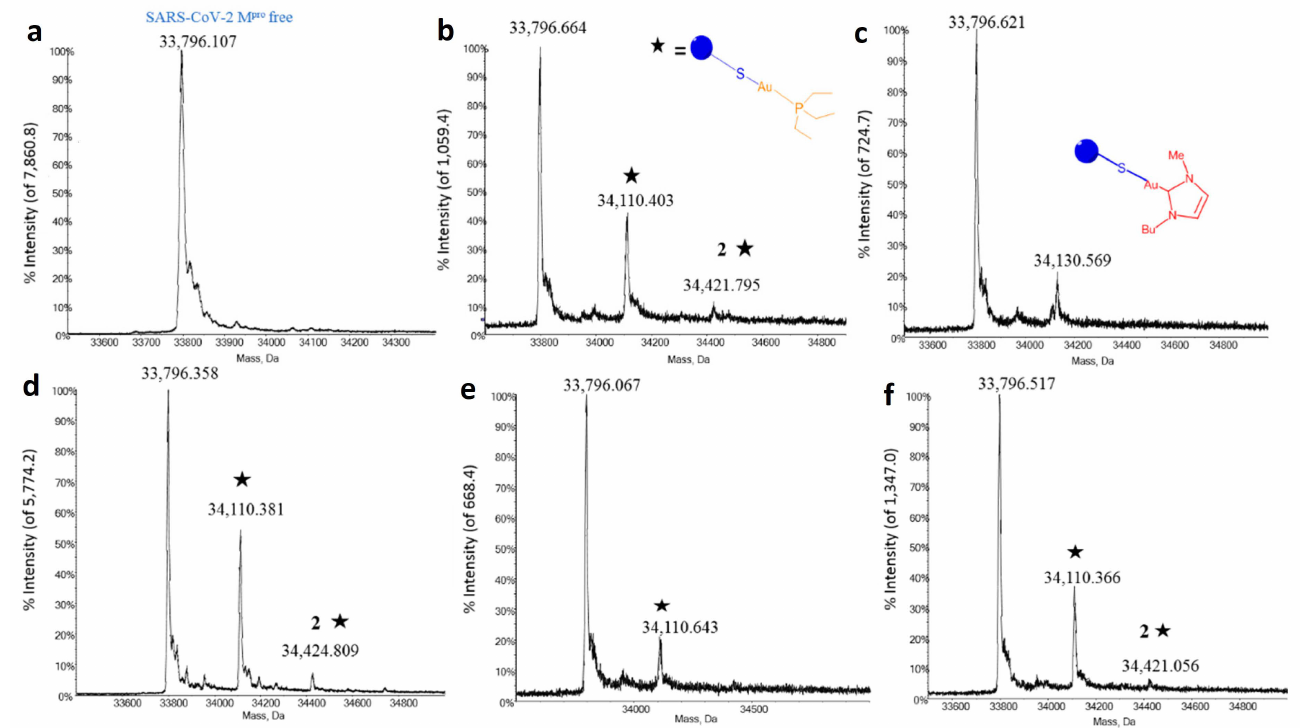
Figure 3. Deconvoluted ESI-QTOF mass spectra of M pro incubated with different gold compounds for 4 h, ( a ) M pro free ( b ) Auranofin ( c ) Au(NHC)Cl ( d ) Au(PEt 3 )Br ( e ) Au(PEt 3 )I ( f ) Au(PEt 3 )Cl. The star indicates the compound moiety that is bound to the protein in the case of Auranofin and its